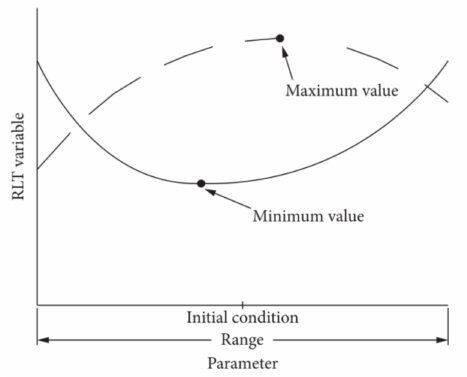
Figure 2. Optimizer